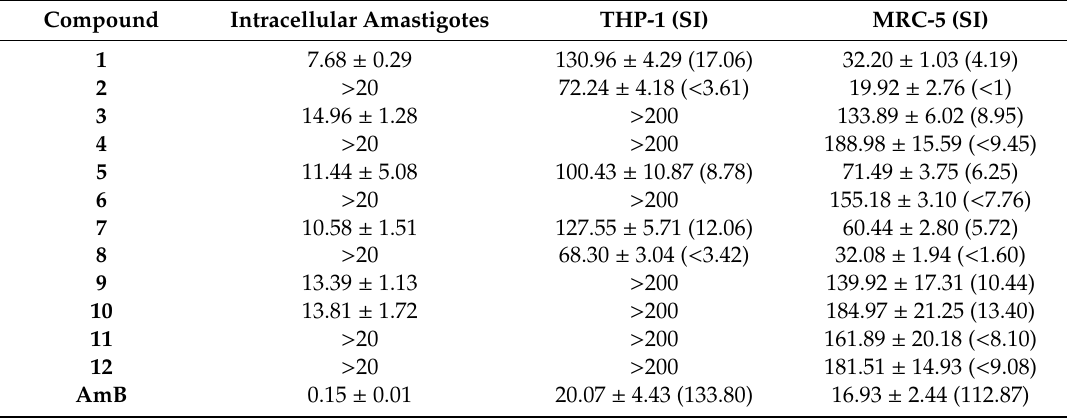
Table 2. Drug susceptibility profile of the C -glycosides sp 2 -IGLs 1 – 12 for intracellular amastigotes of L. donovani (EC 50 values, µ M) and cellular toxicity (MTT assay) in THP-1 and MRC-5 cells (EC 50 values, µ M). Data for the reference drug AmB are also shown a .